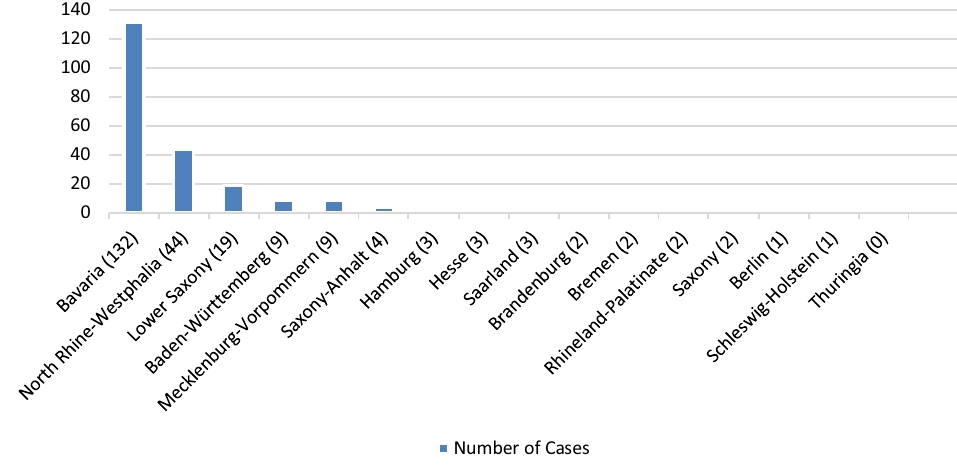
Figure 4. Number of cases decided on by a court in each